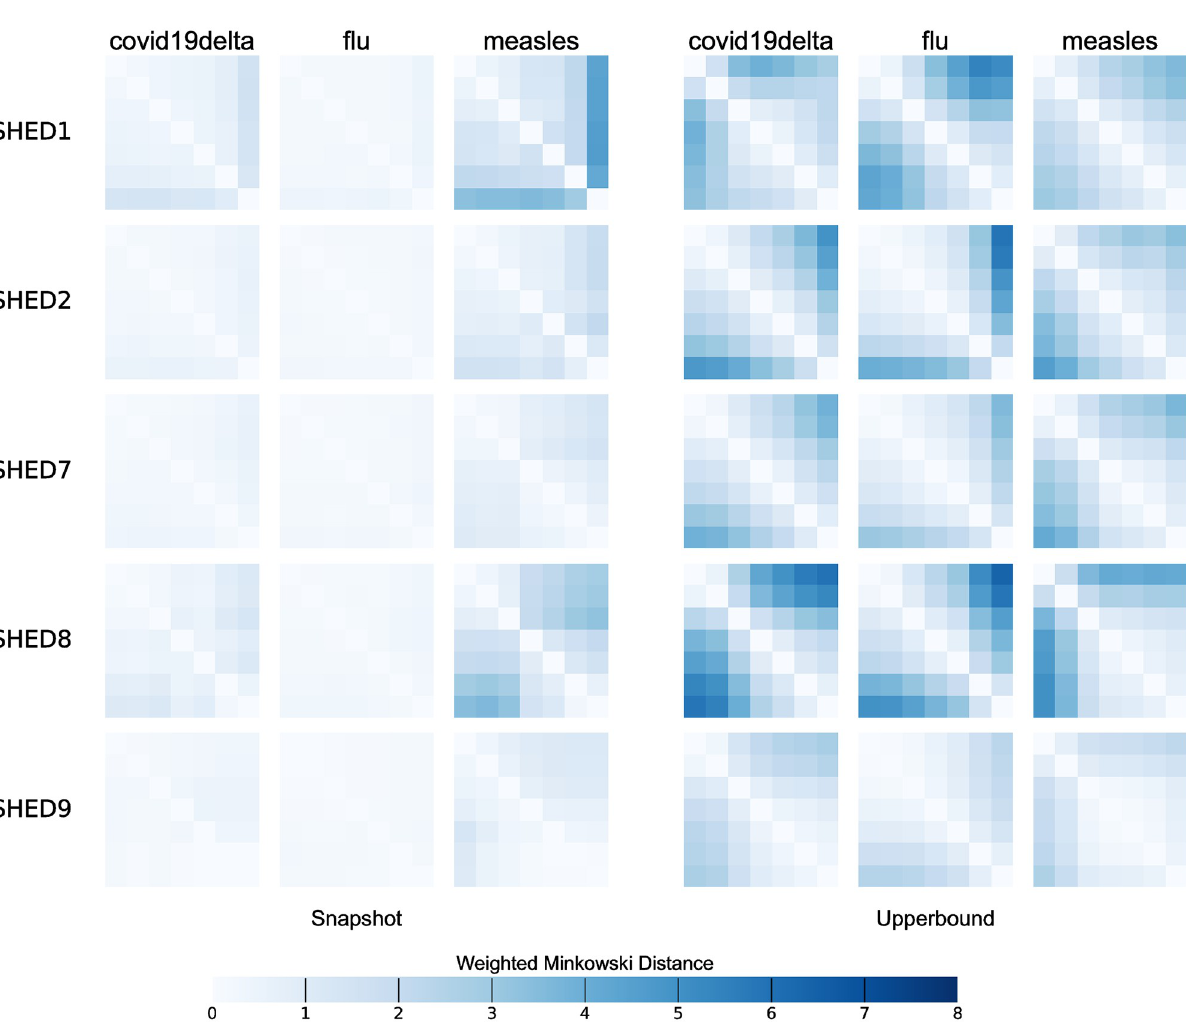
Fig 9. Distance matrix of infection pairs. Two grids of two dimensional (2D) histograms visualize matrices of pairwise weighted-Minkowski distances of frequencies of infections pairs given downsampling methods, disease, and sampling frequencies for underlying populations. All histograms share a color-scale as shown in the legend, with the color shifting from lighter to darker with the increasing degree of dissimilarity. For each matrix, starting from its top left corner, inter-observation intervals are arranged in ascending order— ξ = 5, 10, 30, 60, 90, 180, 360—horizontally from left to right and vertically from top to bottom. We found Snapshot is better at preserving consistent frequencies of infection pairs, particularly with an observation frequency higher than once per half-hour, except for higher R 0 diseases in “diffuse” communities, such as chickenpox and measles in SHED9. For lower R 0 diseases (flu), particularly in “closer” communities like SHED1, the Snapshot method have weighted-Minkowski distance less than two even between the observation frequencies of 5-minute and